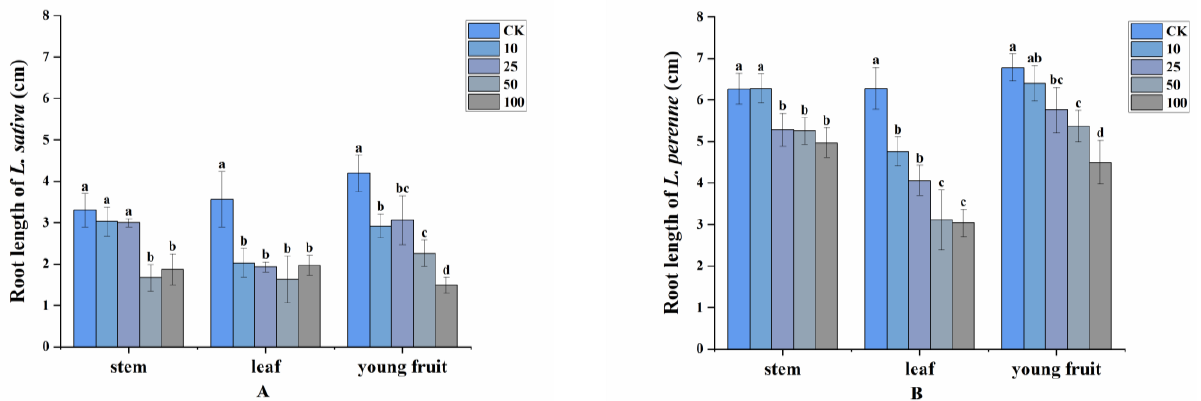
Figure 1. Allelopathic effects of A. villosum volatile compounds on the root length of ( A ): L. sativa and ( B ): L. perenne at 0 g/1.5 L (control, CK), 10 g/1.5 L, 25 g/1.5 L, 50 g/1.5 L and 100 g/1.5 L. Each value is the mean of three replicates ± SD ( n = 30). Means with different lowercase letters indicate significant differences at p < 0.05 level according to ANOVA and Fisher’s LSD test.